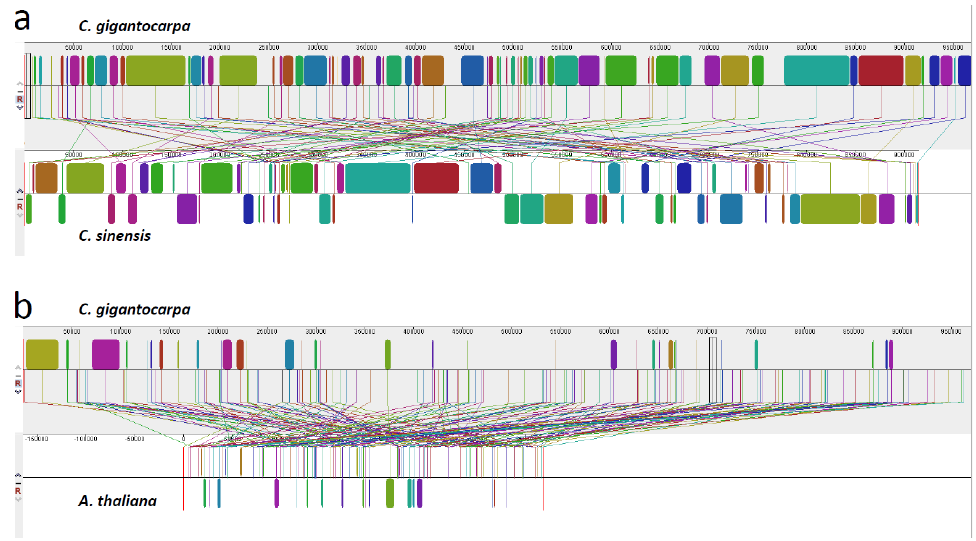
Figure 5. Whole mitochondrial alignments of three species. ( a ) Whole mitochondrial alignments of C. gigantocarpa and C. sinensis ; and ( b ) whole mitochondrial alignments of C. gigantocarpa and A. thaliana .